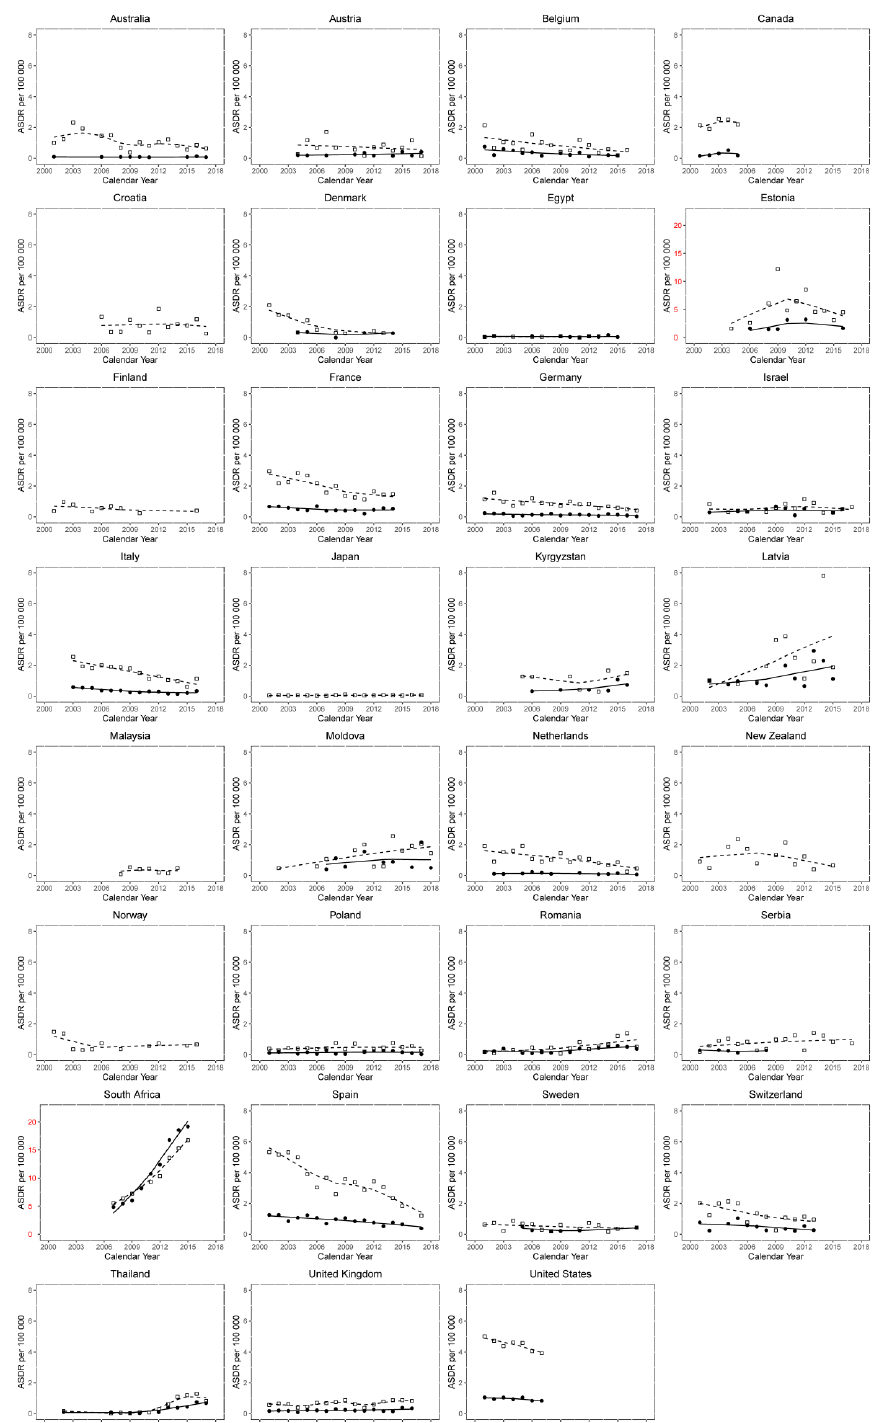
Figure 2. Trends in age-standardized death certification rates per 100,000 for HIV-related cancer. Squares indicate male mortality, whereas circles indicate females. End point for Canada: 2005, USA: 2007, rest of the countries end point varies between